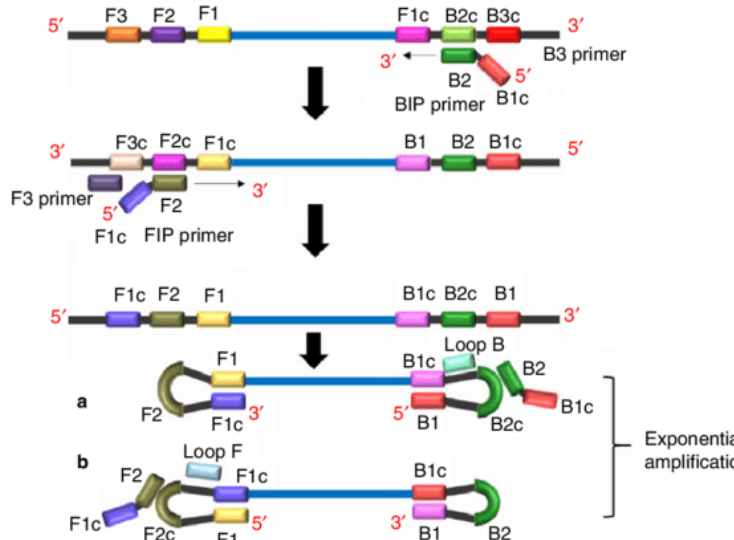
Figure 2. Schematic representation of loop-mediated amplification reaction and its principle. Unlike PCR primer design, LAMP is characterized with four different primers, specifically designed to recognize six distinct regions of the target DNA. Forward inner primer (FIP) consists of a F2 region at the 3’-end and an F1c region at the 5’-end. While the F3 primer (forward outer primer) consists of a F3 region which is complementary to the F3c region of the template sequence. The Backward Inner primer (BIP) is made up of a B2 region at the 3’-end and a B1c region at the 5’-end. B3 primer (backward outer primer) consists of a B3 region which is complementary to the B3c region of the template sequence. In regards to LAMP reaction, amplification begins when F2 region of FIP anneals to F2c region of the target DNA and initiates complementary strand synthesis, and F3 primer anneals to the F3c region of the target and extends, displacing the FIP linked complementary strand. This displaced strand forms a loop at the 5’ -end, which provides the template for BIP, and B2 anneals to B2c region of the template. DNA synthesis is initiated, which results in the formation of a complementary strand and opening of the 5’ -end loop. Subsequently, B3 anneals to B3c region of the target DNA and extends, displacing the BIP linked complementary strand, which forms a dumbbell- shaped DNA. The nucleotides are added to the 3’ -end of F1 by Bst DNA polymerase, which extends and opens up the loop at the 5’ -end. The dumbbell-shaped DNA is converted to a stem – loop structure (a and b), which initiates LAMP cycling (second stage of LAMP reaction). The amplicons formed are a mixture of stem – loop and cauliflower-like structures with multiple loops [49].